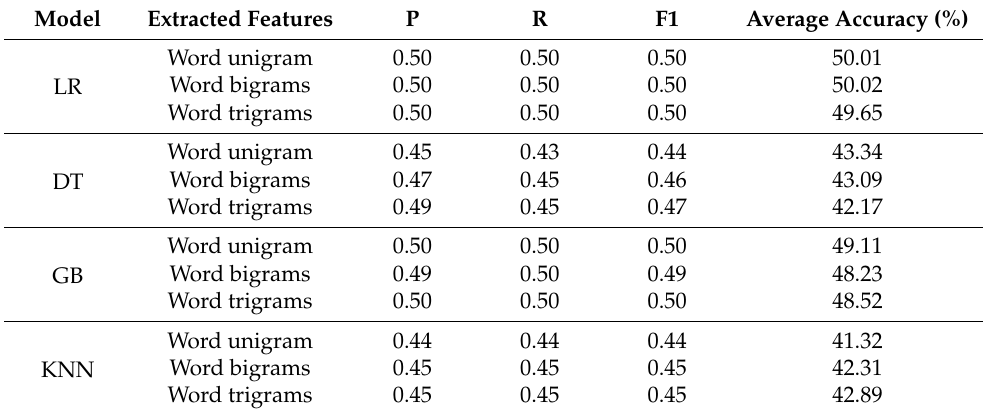
Table 15. Results using conventional machine learning